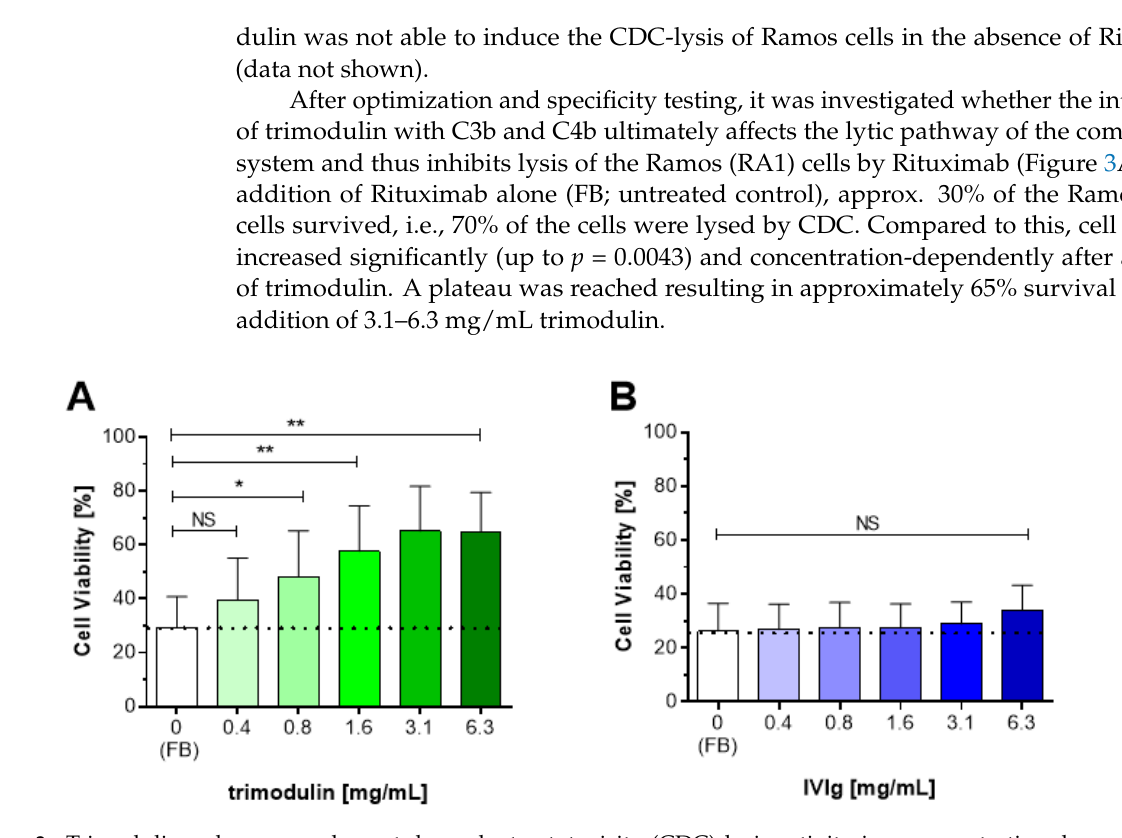
Figure 3. Trimodulin reduces complement-dependent cytotoxicity (CDC) lysis activity in a concentration-dependent manner. Percentage of viable Ramos (RA1) cells after pre-incubation in normal human serum (NHS) with Rituximab (20 µ g/mL) plus increasing concentrations of ( A ) trimodulin or ( B ) IVIg inducing CDC lysis via the classical pathway (CP). Cell viability of Ramos cells was analyzed by staining the membrane attack complex (MAC)-perforated cells with propidium iodide and measurement in a flow cytometer. As control, the FB plus Rituximab (0 mg/mL Ig) was used to determine the base level of CDC (white bars). Bars and error bars indicate mean + SD from six independent experiments performed in duplicates. Statistical analyses were performed using an unpaired Wilcoxon–Mann–Whitney test. Significance is shown ns: non-significant or with asterisks indicating a p -value: * p < 0.05; ** p < 0.01. FB: formulation buffer; CP: classical pathway; SD: standard deviation.